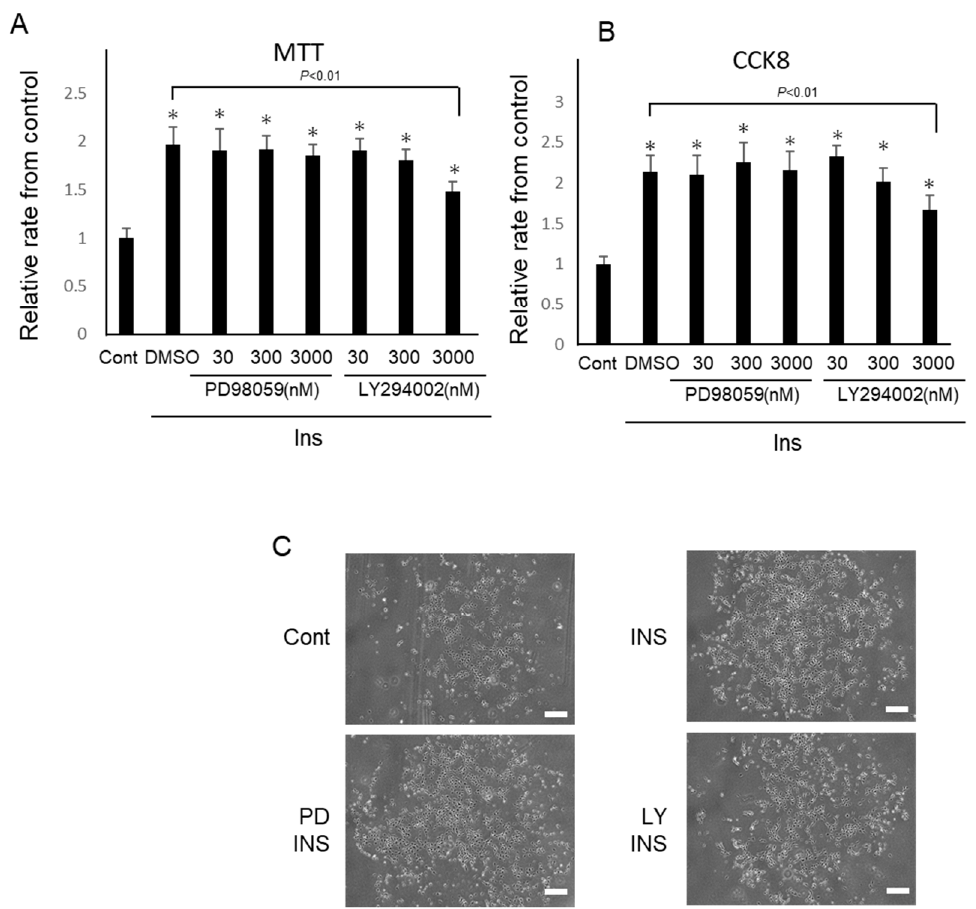
Figure 3. Insulin promotes the proliferation of IFRS1. Cell growth was arrested using serum-free Dulbecco’s Modified Eagle Medium (DMEM) for 12 h. After pre-incubation with LY294002 (30–3000 nM) or PD98059 (30–3000 nM), cells were incubated with insulin (100 nM). ( A ) Cell proliferation was assessed using an MTT assay. ( B ) Cell proliferation was assessed by CCK-8. The results are shown as the mean ± standard error of the mean (SEM). * p < 0.01 versus the control. ( C ) Representative images of the IFRS1 observed under phase-contrast microscopy. (Bar = 200 μ m).